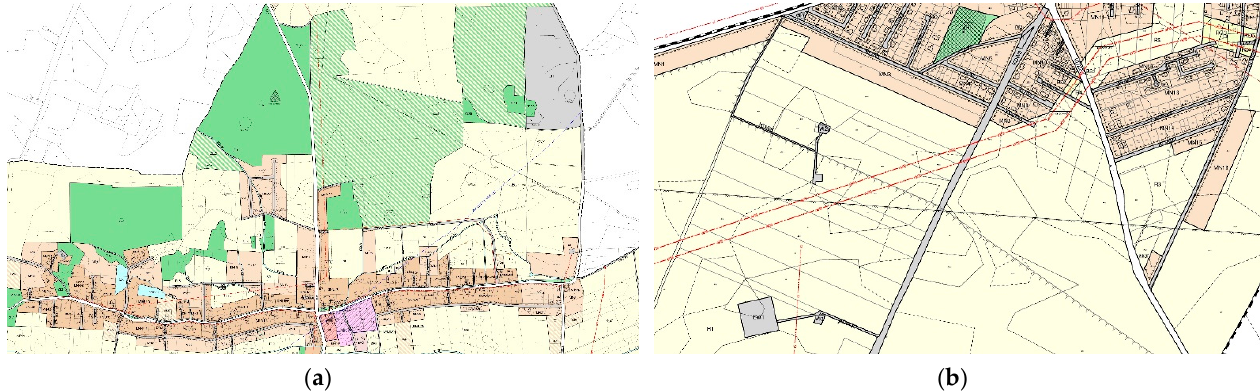
Figure 5. Personnel from the approved local development plan in the Lower Silesia Province, in rural areas, indicating the location of the areas of energy production from renewable sources: ( a ) whose power does not exceed 100 kW—photovoltaics (EF1); ( b ) with a capacity exceeding 100 kW—wind farms (EW1) with a protection zone. Source: [27].